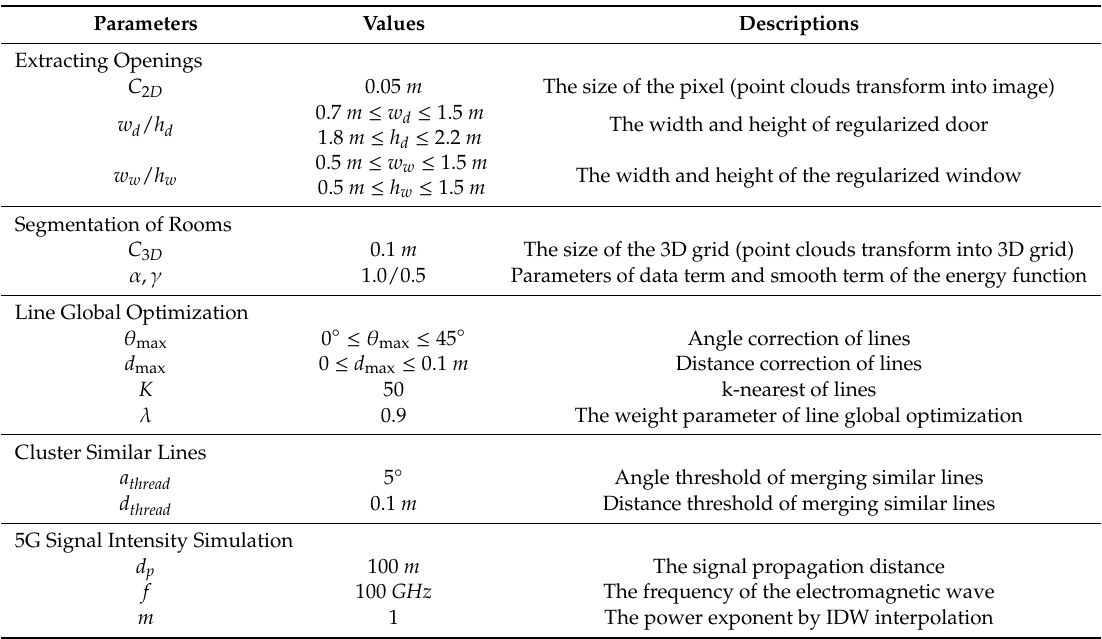
Table 3. Parameters of the proposed indoor structural model